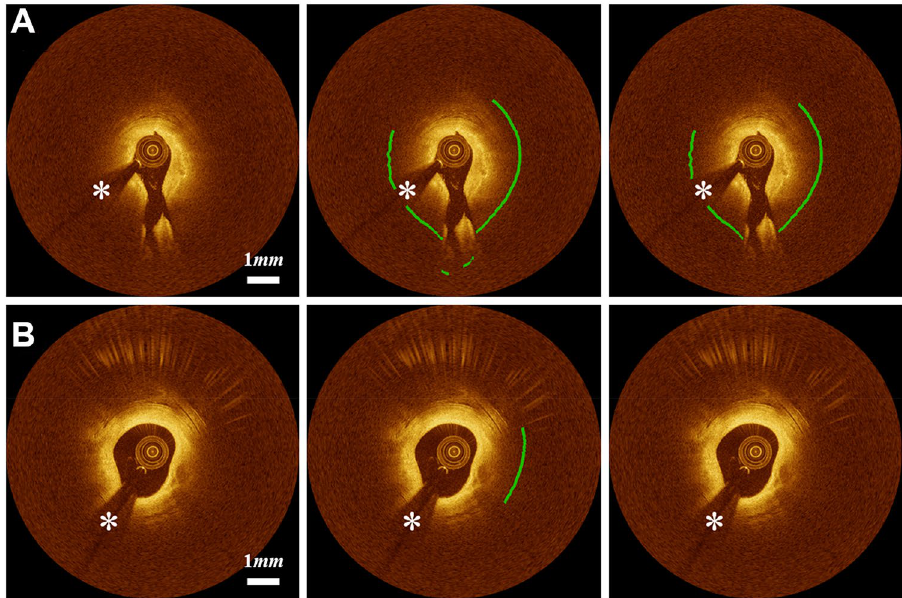
Figure 4. Challenging cases in lipid detection requiring editing. ( A ) The algorithm reasonably identified the lipid location, but showed errors on the side branch regions. ( B ) False lipid prediction often happened to the mixed plaques. The first, second, and third columns are original images, automated results, and manually edited results, respectively. Green is the fibrous cap, and white asterisk (*) indicates the guidewire shadow.